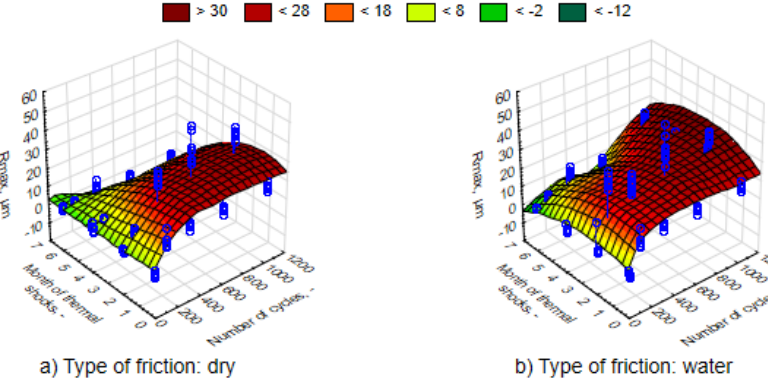
Figure 17. Characteristics of changes in the parameter Rmax, depending on the number of friction cycles, for samples exposed to thermal shocks, ( a ) dry friction, ( b ) wet friction.